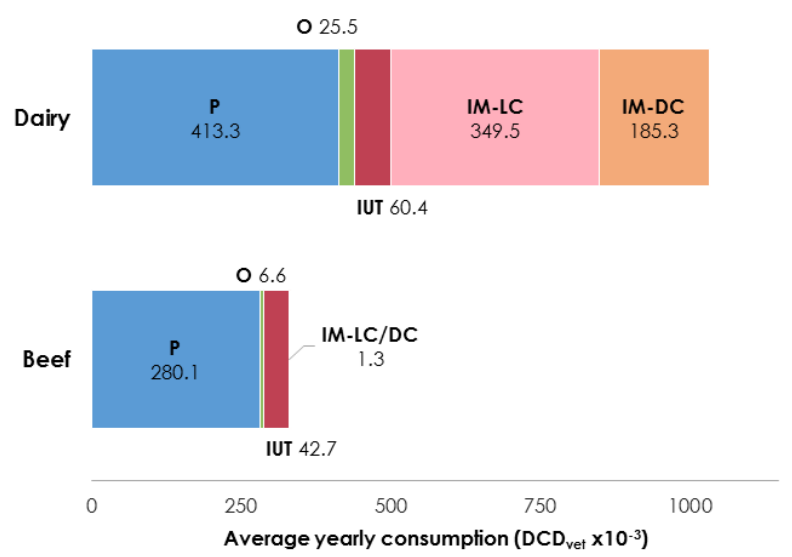
Figure 3. Average yearly consumption (DCD vet /year × 10 − 3 ) per administration route and breeding category (P = parenteral, O = oral, IUT = intrauterine, IM-LC = intramammary lactating cow, IM-DC = intramammary dry cow) (for details see Appendix A, Table A4).